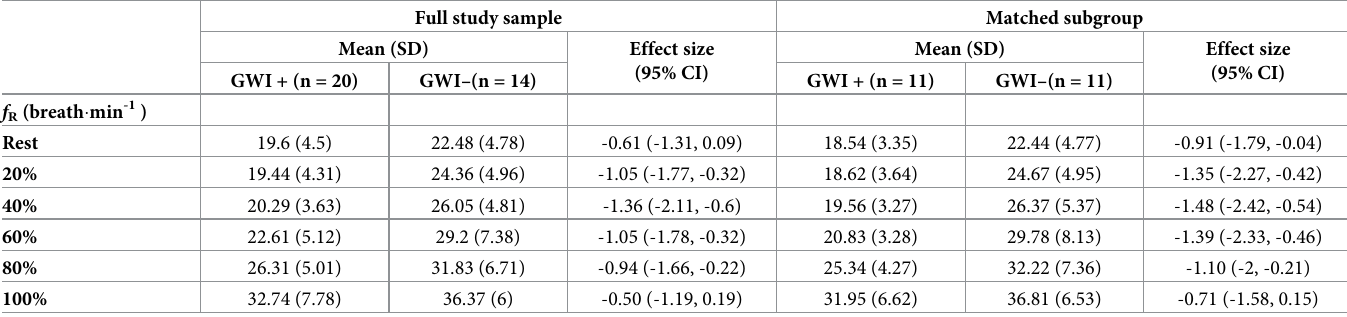
Table 6. Continued comparison of mean (SD) ventilatory patterns between participants with positive and negative Gulf War Illness diagnoses. Full study